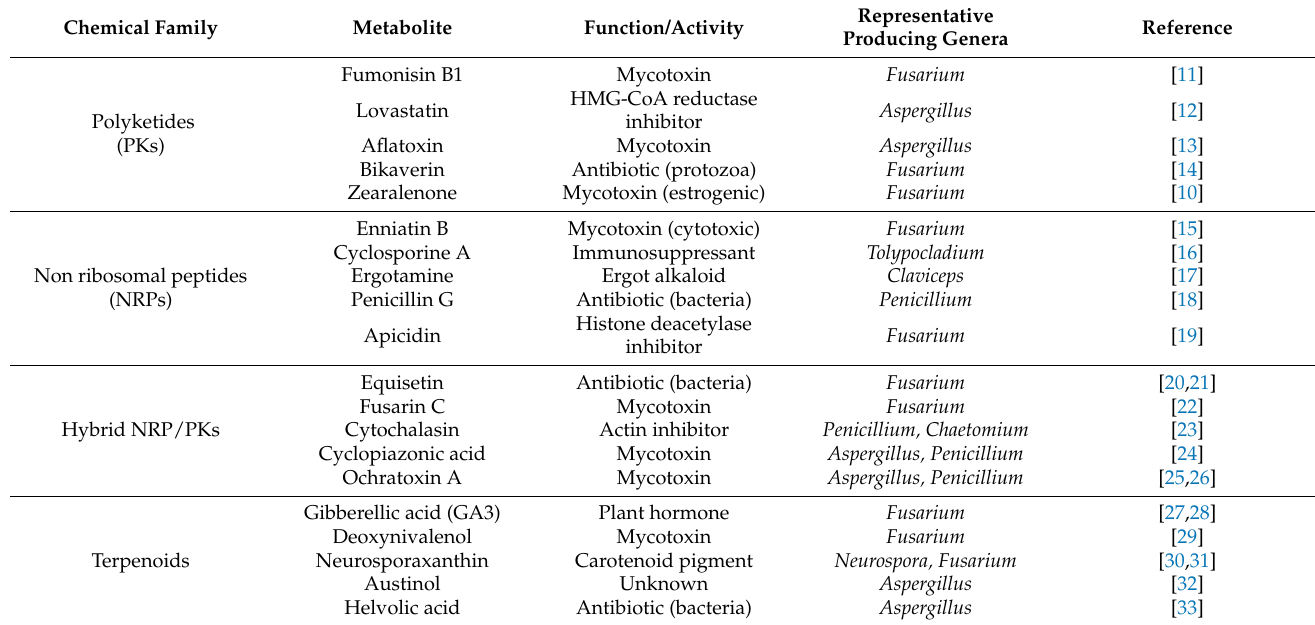
Table 1. A selection of fungal secondary metabolites. Five representative examples are indicated for each SM